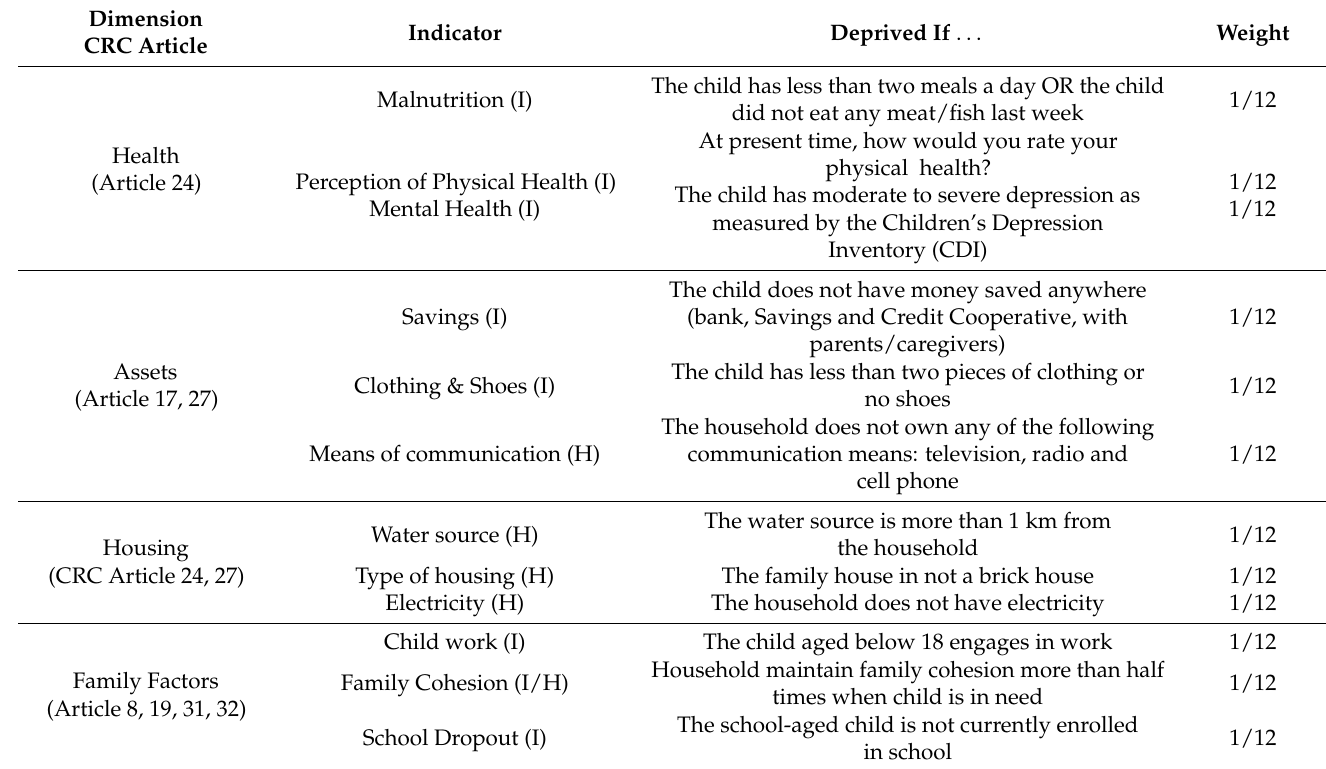
Table 1. Multidimensional Poverty Index (MPI) domains and indicators (measures) and Convention on the Rights of the